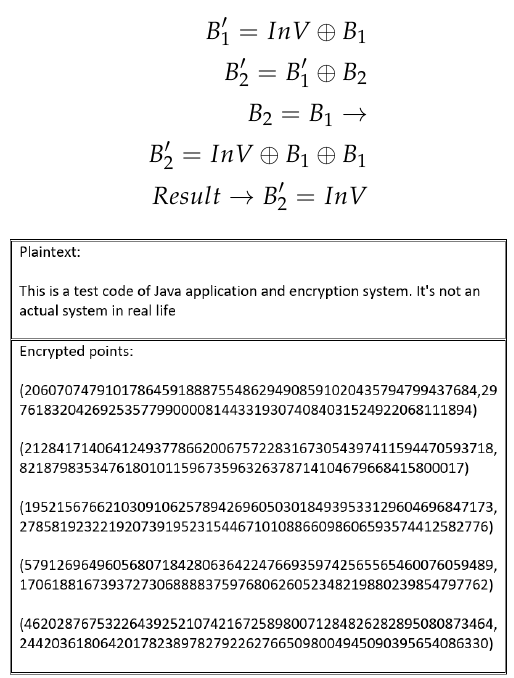
Figure 16. Cipher text generated by first encryption